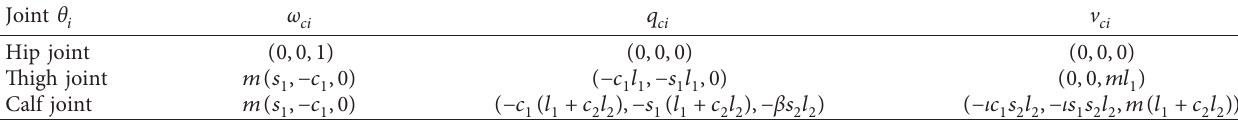
Table 4: Jacobian matrix between the foot end and the hip